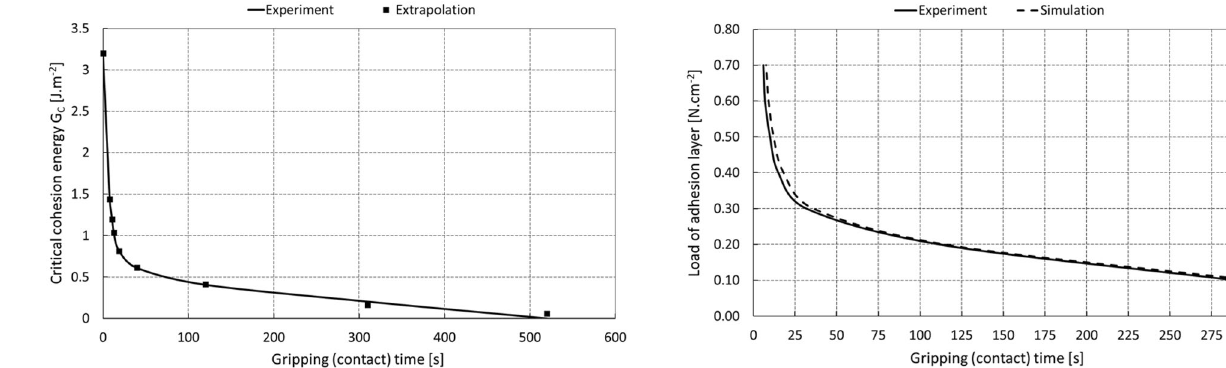
Fig. 19 Change in critical cohesive energy over time